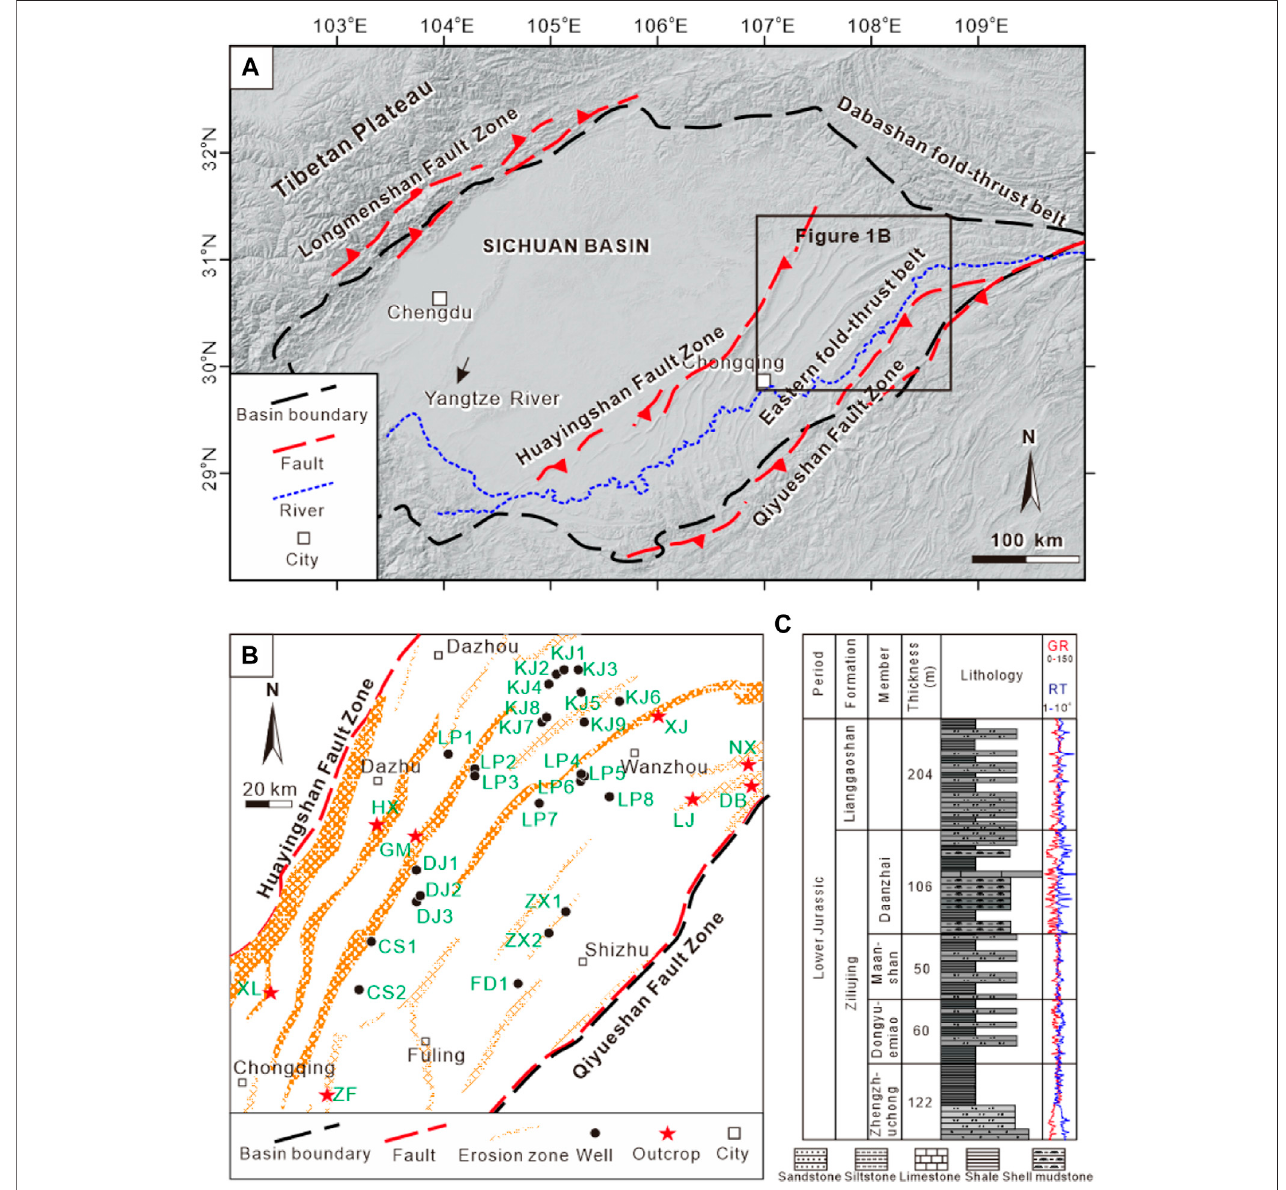
FIGURE 1 | (A) Simpli fi ed tectonic map showing the location of the Sichuan Basin. (B) Well and outcrop locations of the study area. (C) Lithology pro fi les of lacustrine shales in the Lower Jurassic of the Sichuan basin.